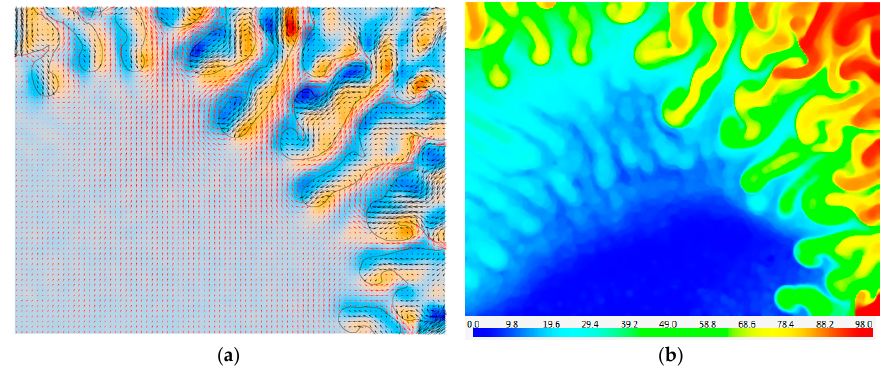
Figure 9. ( a ) Phase-separated PIV measurement results where red vectors are in water, black vectors are in the magnetic fluid (every third vector is shown). Black continuous line is the phase boundary, and the blue and orange colors represent vorticity. ( b ) Magnetic fluid concentration field estimated using absorption imaging. FoV is 1.6 mm × 1.2 mm.